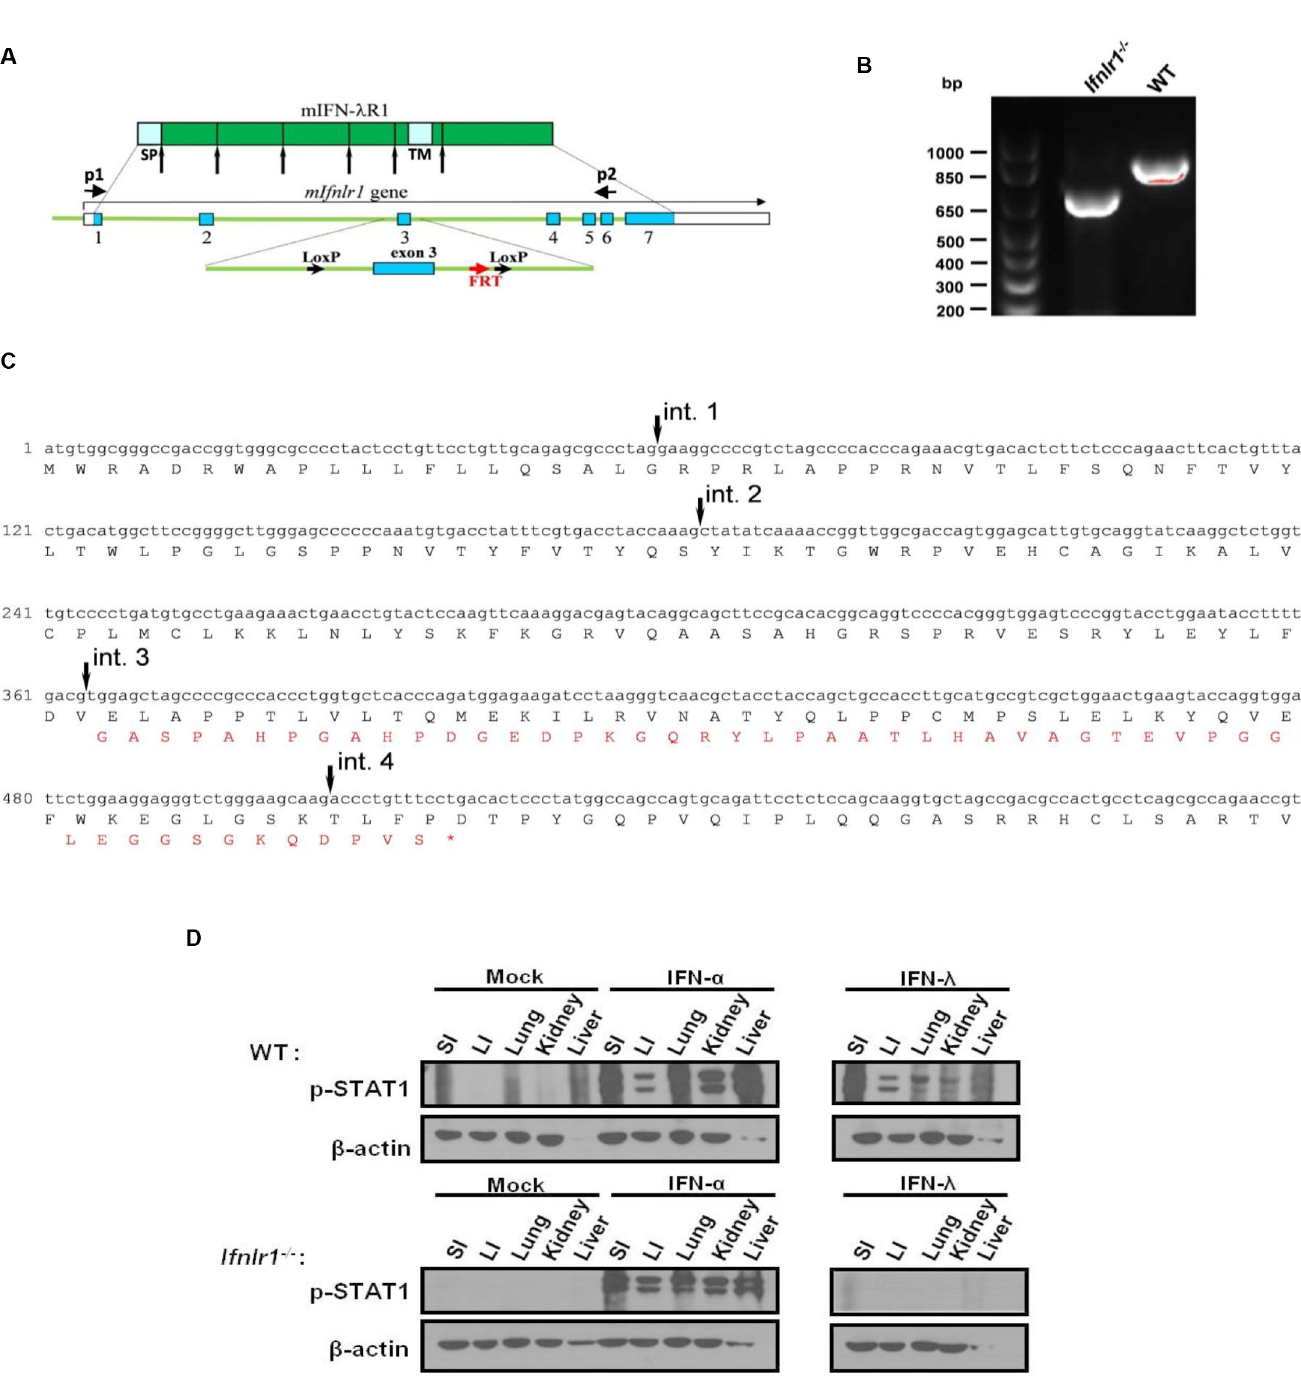
Fig 1. Generation and evaluation of IFN- λ R1 KO mice. (A) The exon-intron structure of the Ifnlr1 gene and the outline of the KO targeting vector are schematically shown. Exon 3 of the mouse Ifnlr1 gene was flanked by two loxp sites introduced into corresponding introns away from the splice signals. Remaining FRT site and positions of two primers (p1 and p2) are schematically mapped. (B) RNA samples were obtained from kidney cells of WT and Ifnlr1 -/- mice and used for RT-PCR with Ifnlr1 -specific primers (p1 and p2) flanking exon 3. The sizes of the PCR fragments were determined by the agarose gel electrophoresis with 100 base pair DNA ladder shown in the left lane. (C) Sequencing of the PCR fragment from the Ifnlr1 -/- mice revealed splicing of exon 2 into exon 4 of the Ifnlr1 gene. A part of the Ifnlr1 gene transcript with original reading frame (black letters) and a shifted reading frame with a premature stop codon (orange letters) that was generated as a result of exon 3 skipping are shown. Arrows indicated positions of introns 1 through 4. (D) 8-day-old WT and Ifnlr1 -/- pups were intradermally injected with 1 μ g human IFN- α A/D (IFN- α ) or murine IFN- λ 2 (IFN- λ ), 30 min later the indicated organs (small intestine (SI), large intestine (LI), lung, kidney and liver) were collected and analyzed for the presence of phosphorylated STAT1 (pSTAT1), as evidence of signaling through the IFN- α R or IFN- λ R, by immunoblotting with pSTAT1-specific antibody. Immonoblotting with β actin antibody was used to evaluate equal loading.